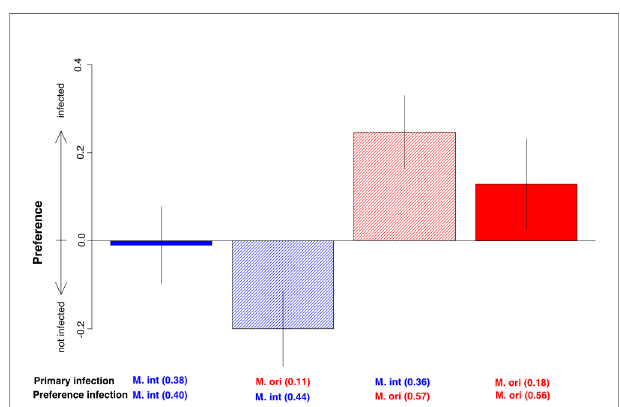
FIGURE 6 | Preference of Mytilicola intestinalis (M. int, blue) and Mytilicola orientalis (M. ori, red) for hosts with or without a primary infection in host choice experiment. Preference is expressed as the difference of infection rate in hosts with primary infection minus the infection rate of the host without primary infection. Numbers in the x-axis labels show the overall infection rate of the respective parasite species in both infection rounds. Conspeci fi c combinations of primary and preference infections have solid bars and hetero-speci fi c combinations are hashed. The positive values for M. orientalis show a general preference for host with primary infections in both con- and hetero-speci fi c preference infections (estimate = 0.539 ± 0.140, t = 3.850, p < 0.001). Hetero-speci fi c showed signi fi cantly different infection preferences (estimate = -0.475 ± 0.207, t = -2.290, p = 0.028) indicating that M. intestinalis rather showed avoidance of mussels infected with M. orientalis and ambivalence towards mussels infected with M. intestinalis , while M. orientalis showed a strong preference for mussels previously infected with M. intestinalis